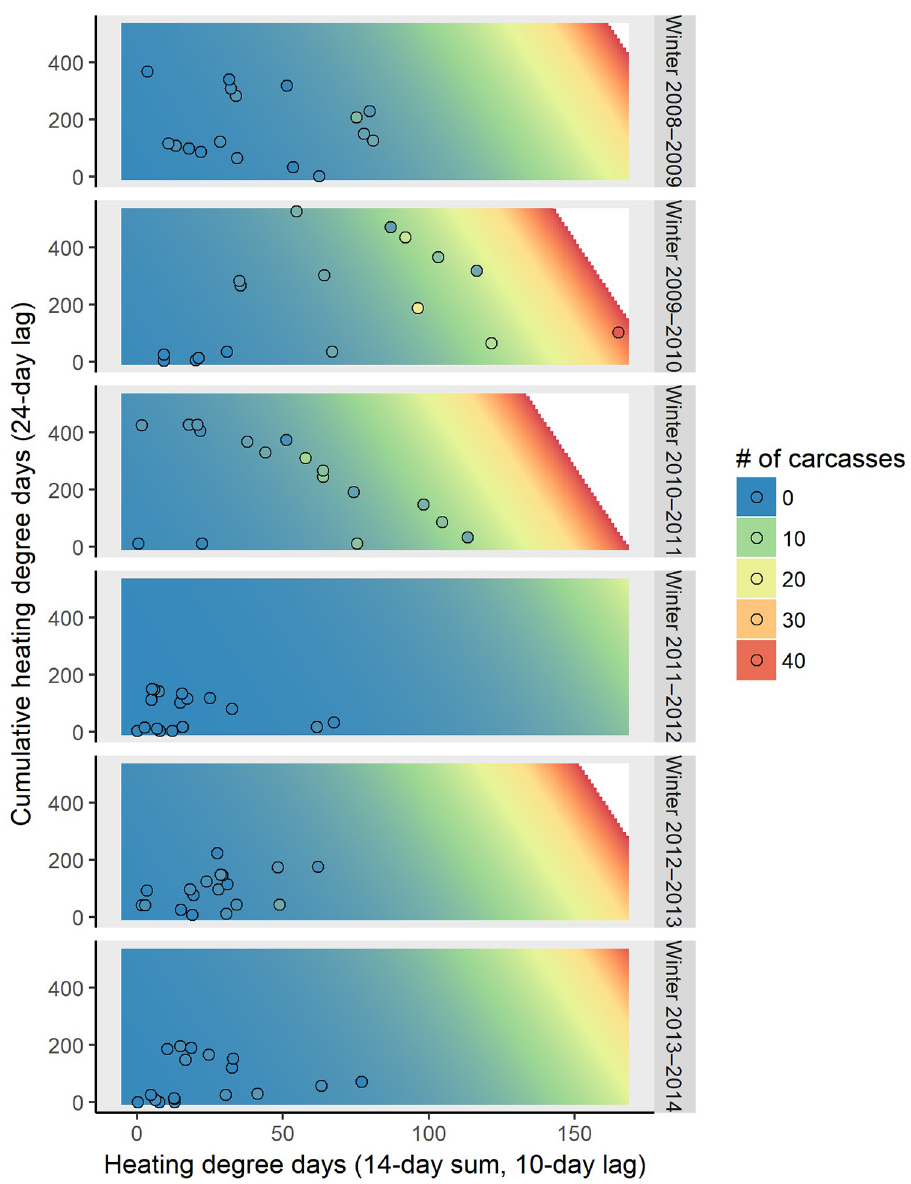
Fig 4. The predicted 7-day counts of cold-related manatee carcasses reported in the central-east region using air temperature based on the winter (each panel), short-term (14-day sum, lagged by 10 days; x-axis) and cumulative temperature effects (lagged by 24 days; y-axis) from the top-ranked model. Each panel represents the observed (circles) and predicted (colored area) number of cold-related carcasses reported over 7 days for each winter. The background color represents the predicted number of cold-related carcasses reported over 7 days, and the color of the circles represent the observed number of cold-related carcasses reported over 7 days. The scale for the number of carcasses is continuous (from blue to red), but for the ease of visualization, the legend displays the colors at intervals of 10 carcasses. We did not make predictions for the number of expected carcasses above the highest number reported during a 7-day period (area in